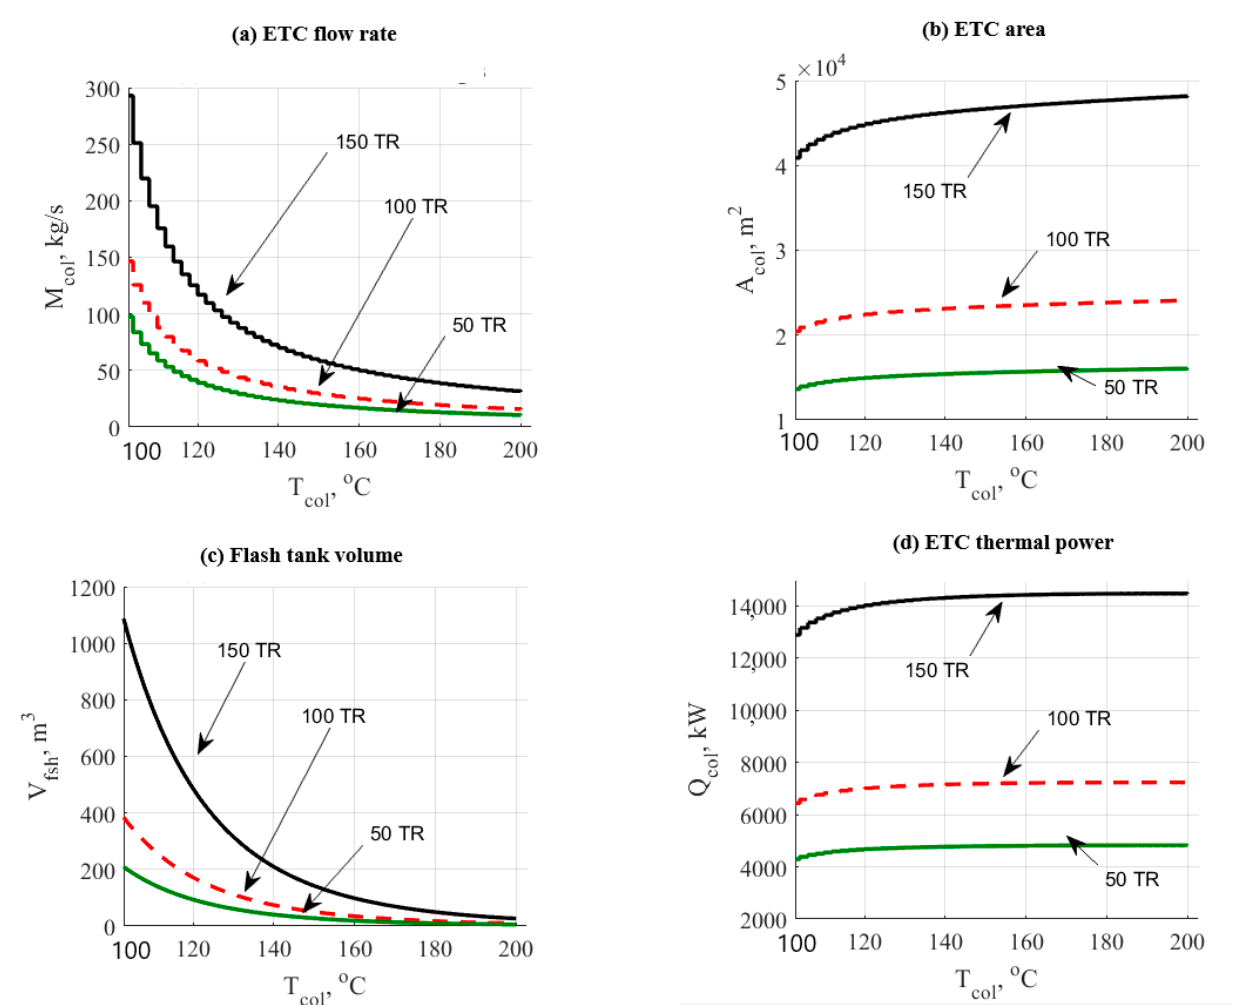
Figure 6. Data results for ETC/NH3 ‐ H2O cycle vs. variation in upper temperature of the solar field. ( a )Collector flow rate. ( b )Solar collector area. ( c )Flash tank volume. ( d )Solar thermal power.